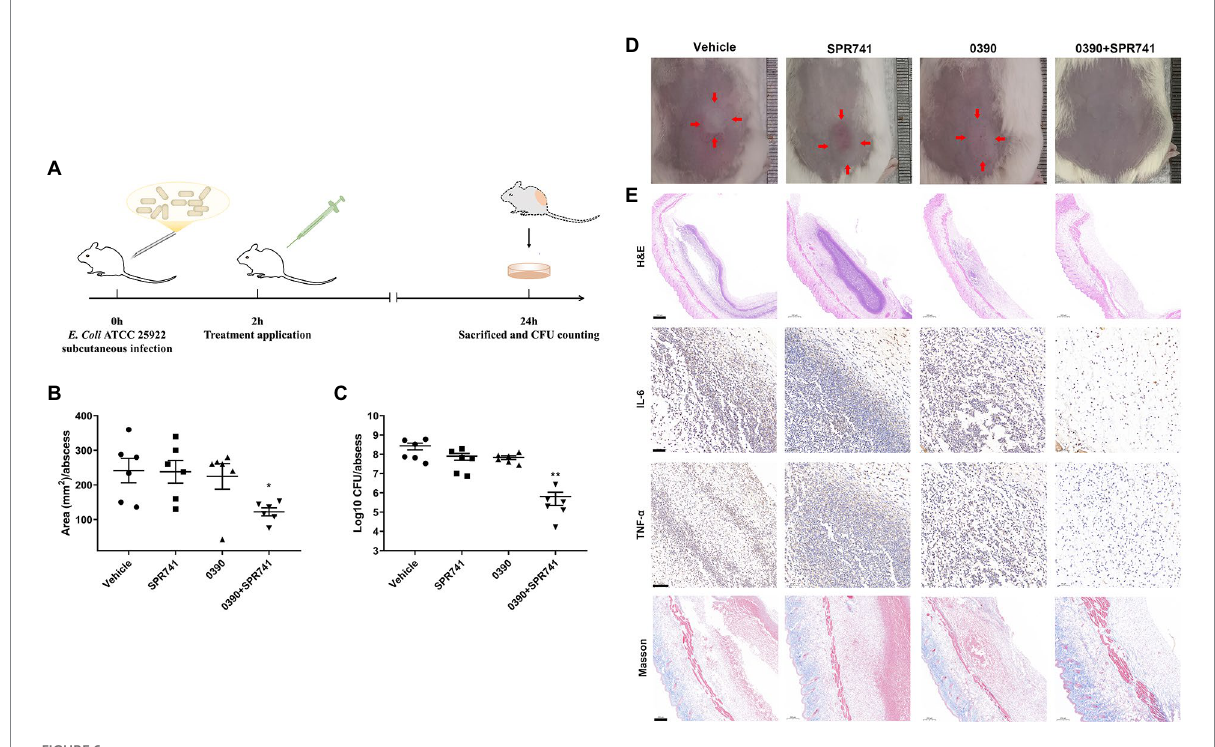
FIGURE 6 In vivo synergistic antimicrobial efficacy of 0390 and SPR741 in combination in a subcutaneous infection model. (A) Workflow of the in vivo infection model’ construction. Mice ( n = 6 mice/group) were subcutaneously injected with 0.5% DMSO, 0390, and SPR741 alone or in combination. (Vehicle, 0.5% DMSO; SPR741, 20 mg/kg; 0390, 20 mg/kg; 0390 + SPR741, and 20 + 20 mg/kg). (B) Areas, (C) viable cell counts, and (D) representative images of abscess were detected. (E) Abscess histological analysis by using H&E staining, Masson’s trichrome staining, and immunohistochemical staining of IL-6 and TNF- α were evaluated. Vehicle group is used for comparison. * p < 0.05, ** p <